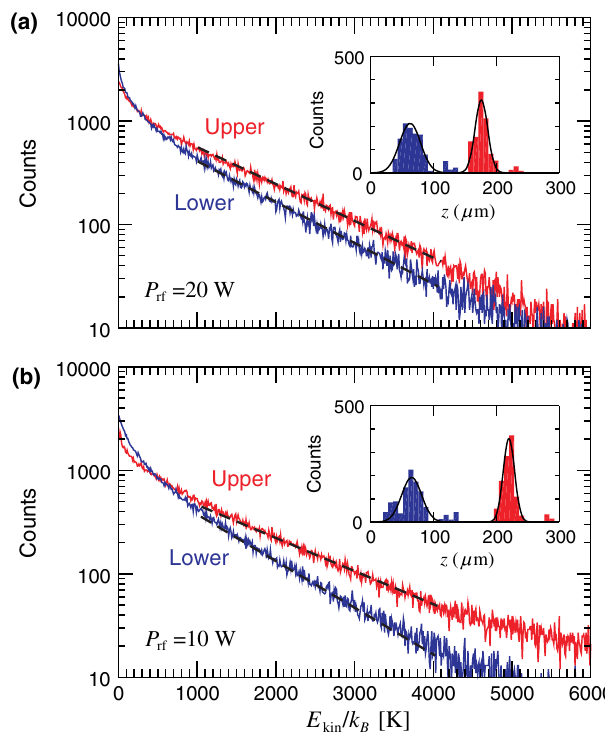
FIG. 4. Kinetic energy distribution for microparticles in mono- layers. Shown are the energy distributions measured for two different values of the rf discharge power P height difference H between the upper and lower layers. The insets depict the height histograms for particles in the layers; the solid lines are Gaussian fits. (a) P and the temperatures of the upper and lower layers are estimated as T U ≃ 1250 K and T L ≃ 1100 K, respectively (from the Maxwellian fit, shown by the dashed lines). (b) P H ≃ 150 μ m, and the respective temperatures are T and T L ≃ 1000